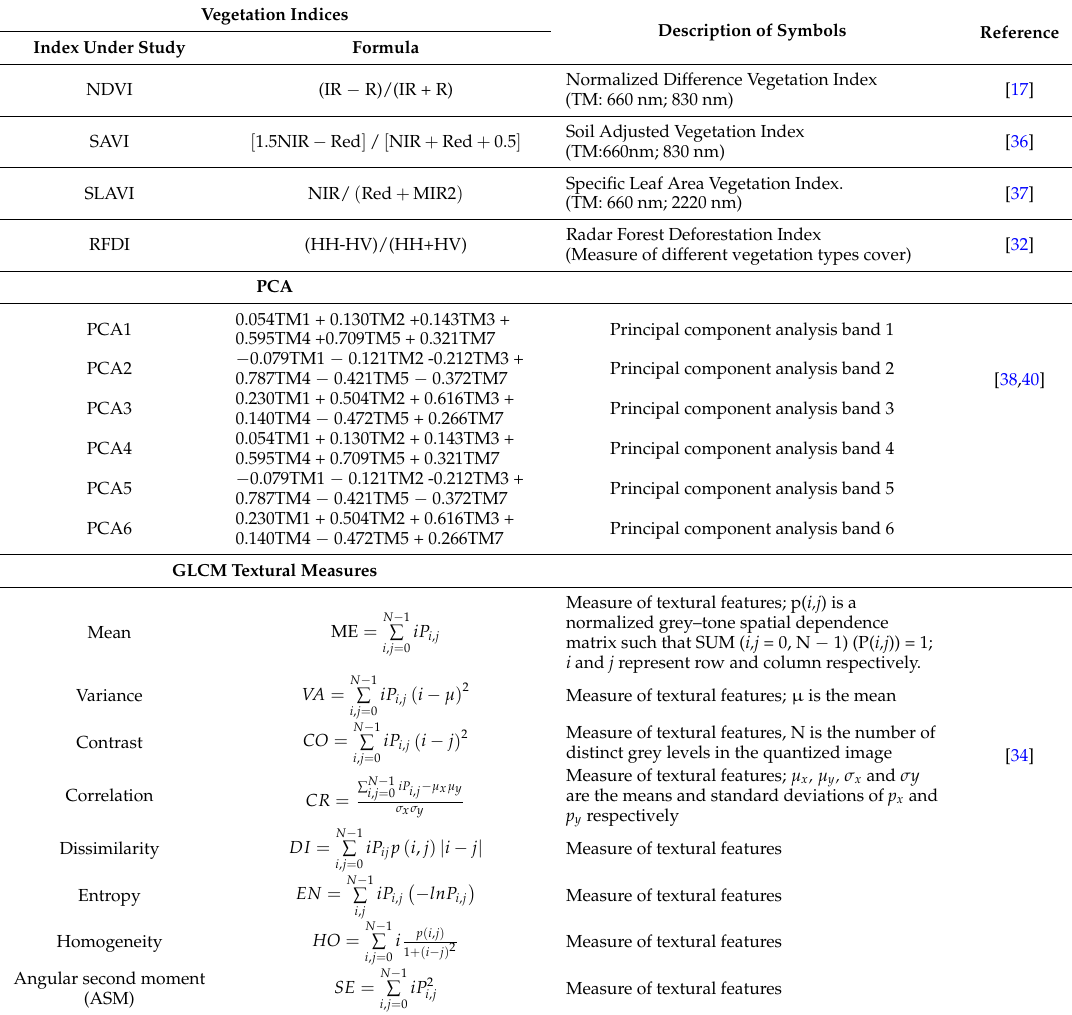
Table 3. Vegetation and textural indices used in this